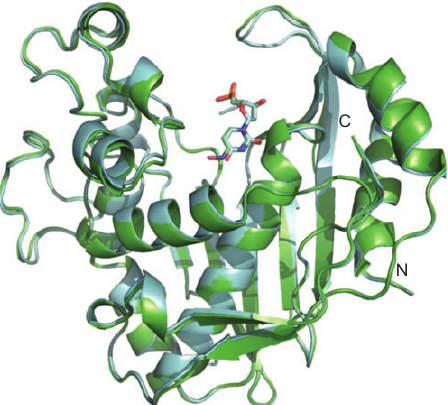
Figure 2 Superimposition of subunits A in mTS-N 4 -OH-dCMP (green) and mTS-dUMP (cyan) complexes. Ligands, N 4 -OH-dCMP and dUMP, are shown as sticks. C- and N-termini of the protein chain are